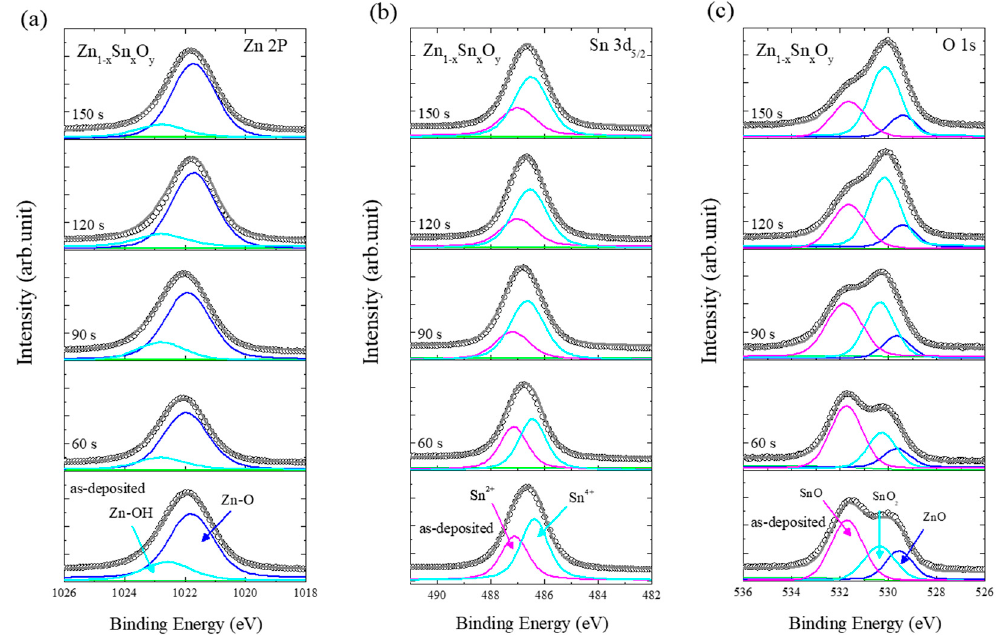
Figure 4. XPS results for Zn 2 p , Sn 3 d and O 1 s core levels as a function of O 2 plasma treatment time for the Zn 0.6 Sn 0.4 O y thin films. ( a ) The Zn 2 p 3/2 was deconvoluted with two components for Zn–O and Zn–OH bonds, ( b ) the Sn 3 d 5/2 was deconvoluted with two components for Sn 4+ , and Sn 2+ , ( c ) the O 1 s was deconvoluted with three components for SnO, SnO 2 , and ZnO bonds.